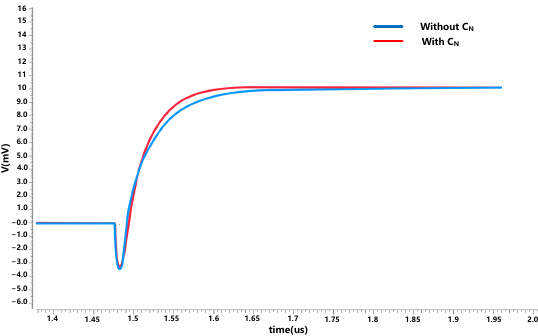
Figure 7. Schematic of the FFMC OTA used in the first integrator.